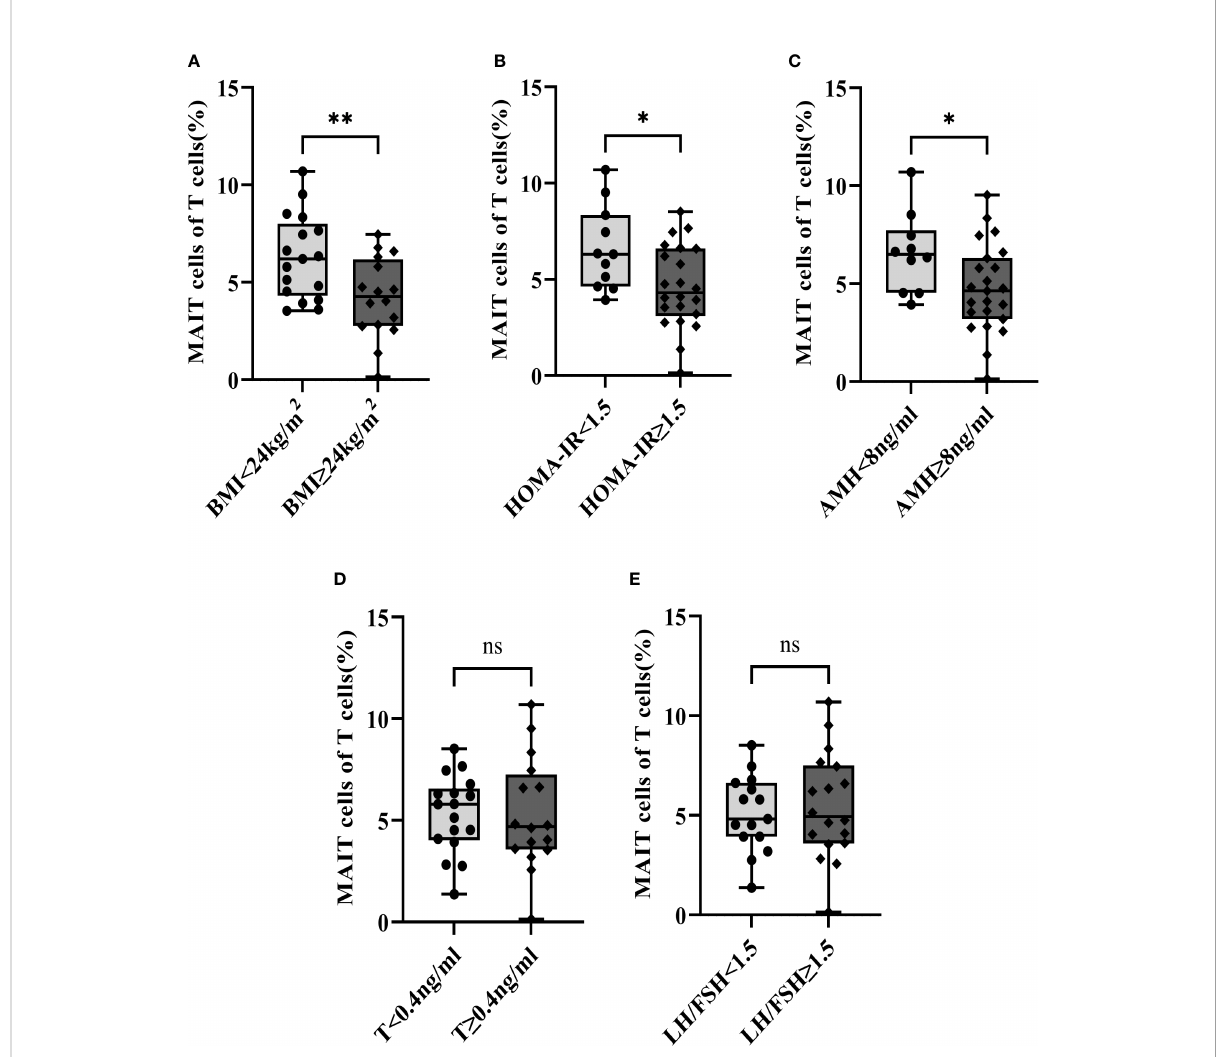
FIGURE 3 Subgroup analysis of the frequencies of MAIT cells of T cells in PCOS patients by BMI, HOMA-IR, AMH, T, and LH/FSH. (A) BMI; (B) HOMA-IR; (C) AMH; (D) T; (E) LH/FSH. *, p<0.05, **, p<0.01, ns, not signi fi